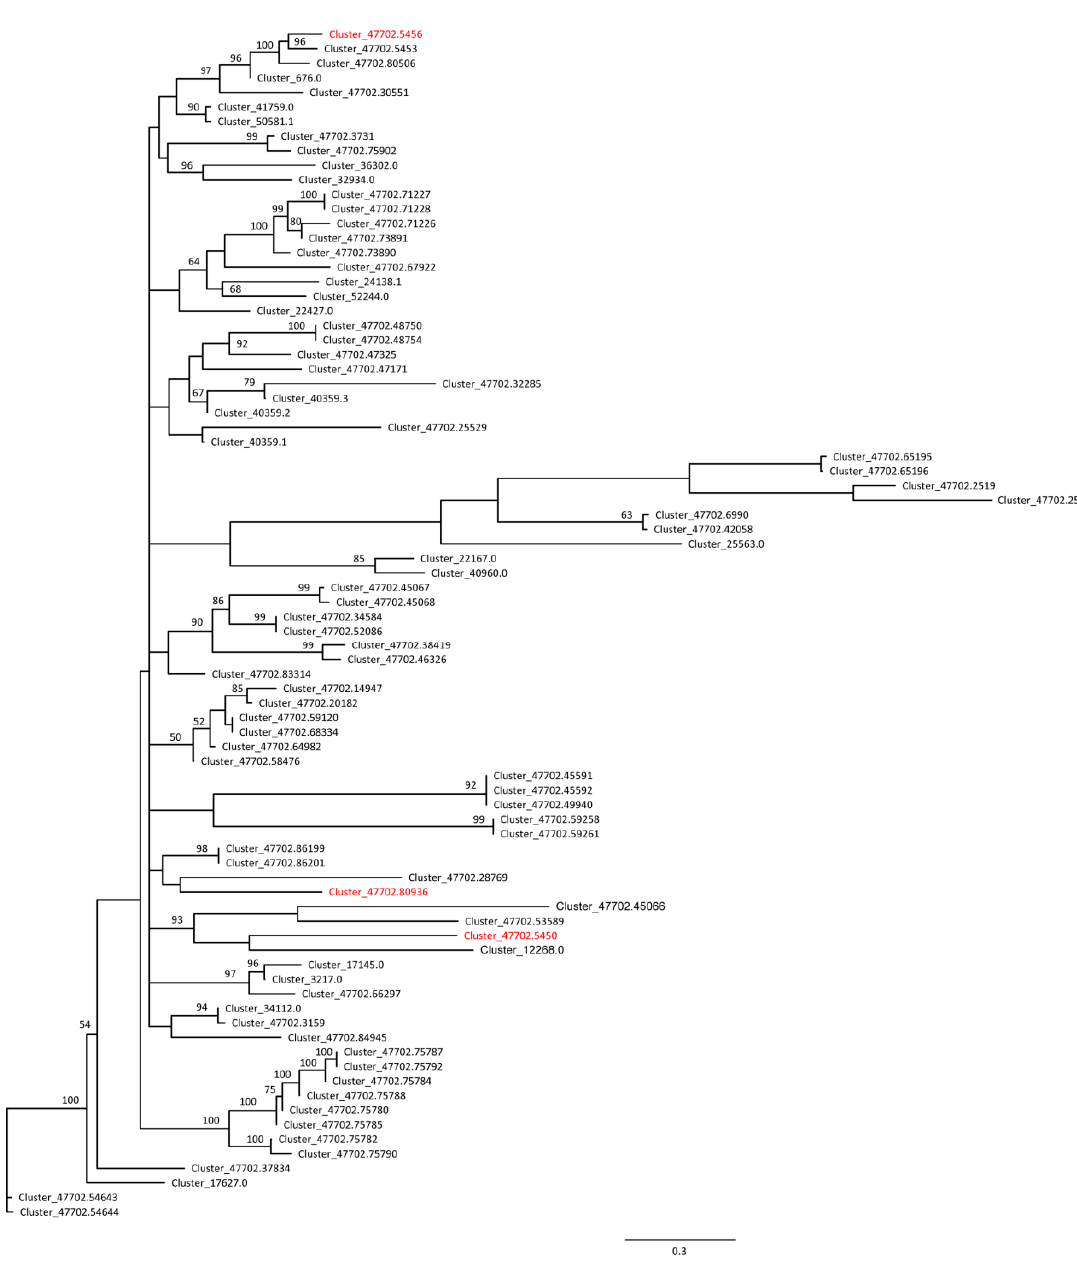
Figure 5. The NJ (neighbor joining) tree of putative 100 MADS box TF (transcription factor) genes in Eucommia ulmoides . The differentially expressed MADS genes between the males and females of E. ulmoides are indicated in red. Support values >50% were shown above the nodes.